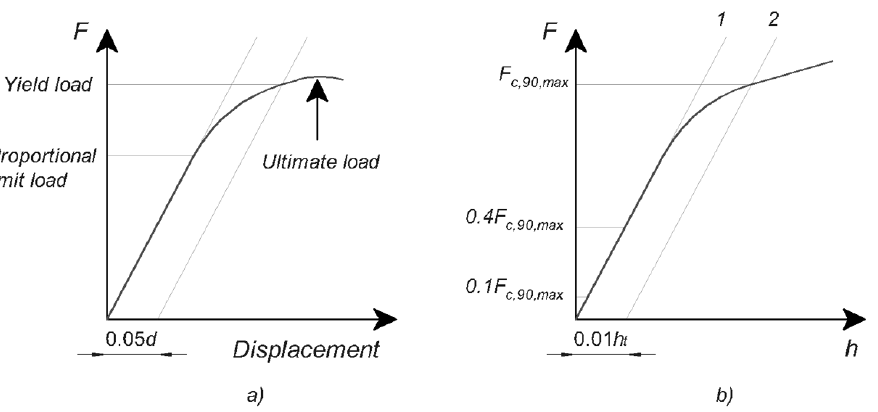
Figure 5. Method for the determination of the yield point according to: ( a ) ASTM D 5764-97a (left) and ( b ) EN 408 (right).